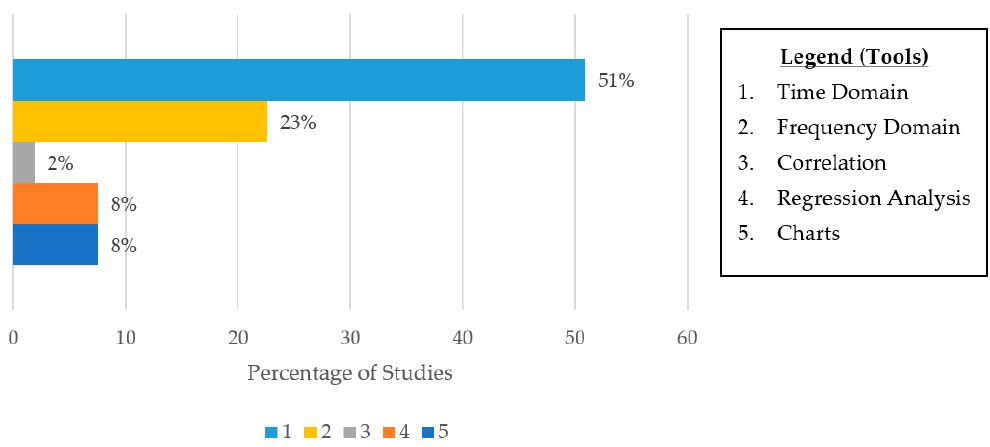
Figure 12. Distribution of the statistical tools utilised by the reviewed studies.